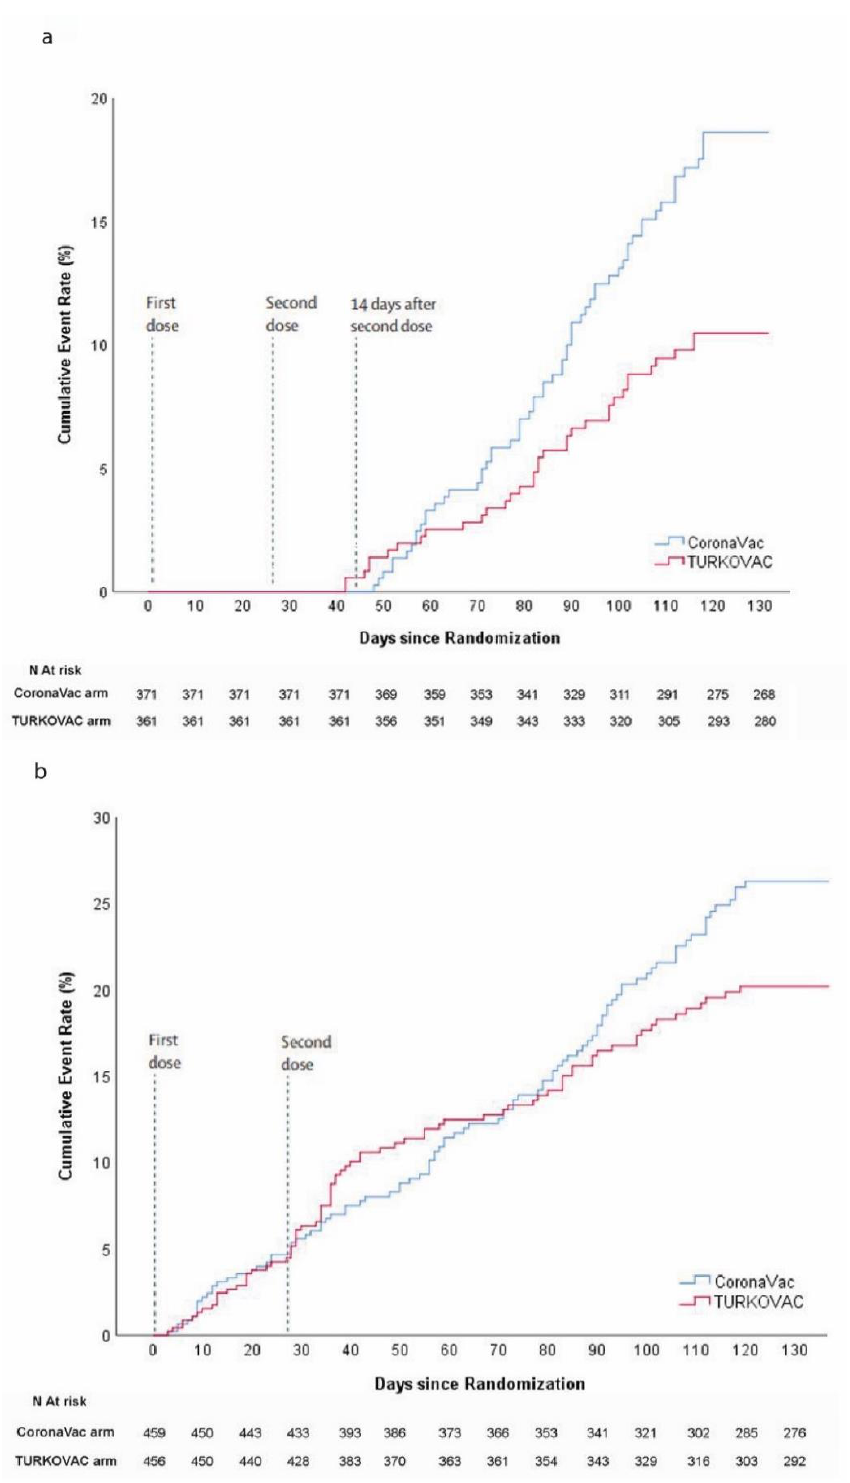
Figure 2. Cumulative incidence curves for COVID-19 cases in both study arms: ( a ) in the modified per-protocol analysis, vaccine efficacy was assessed by analyzing cases starting 14 days after the second dose of vaccination, and ( b ) in the modified intention-to-treat population, cumulative incidence curves are given starting after randomization.